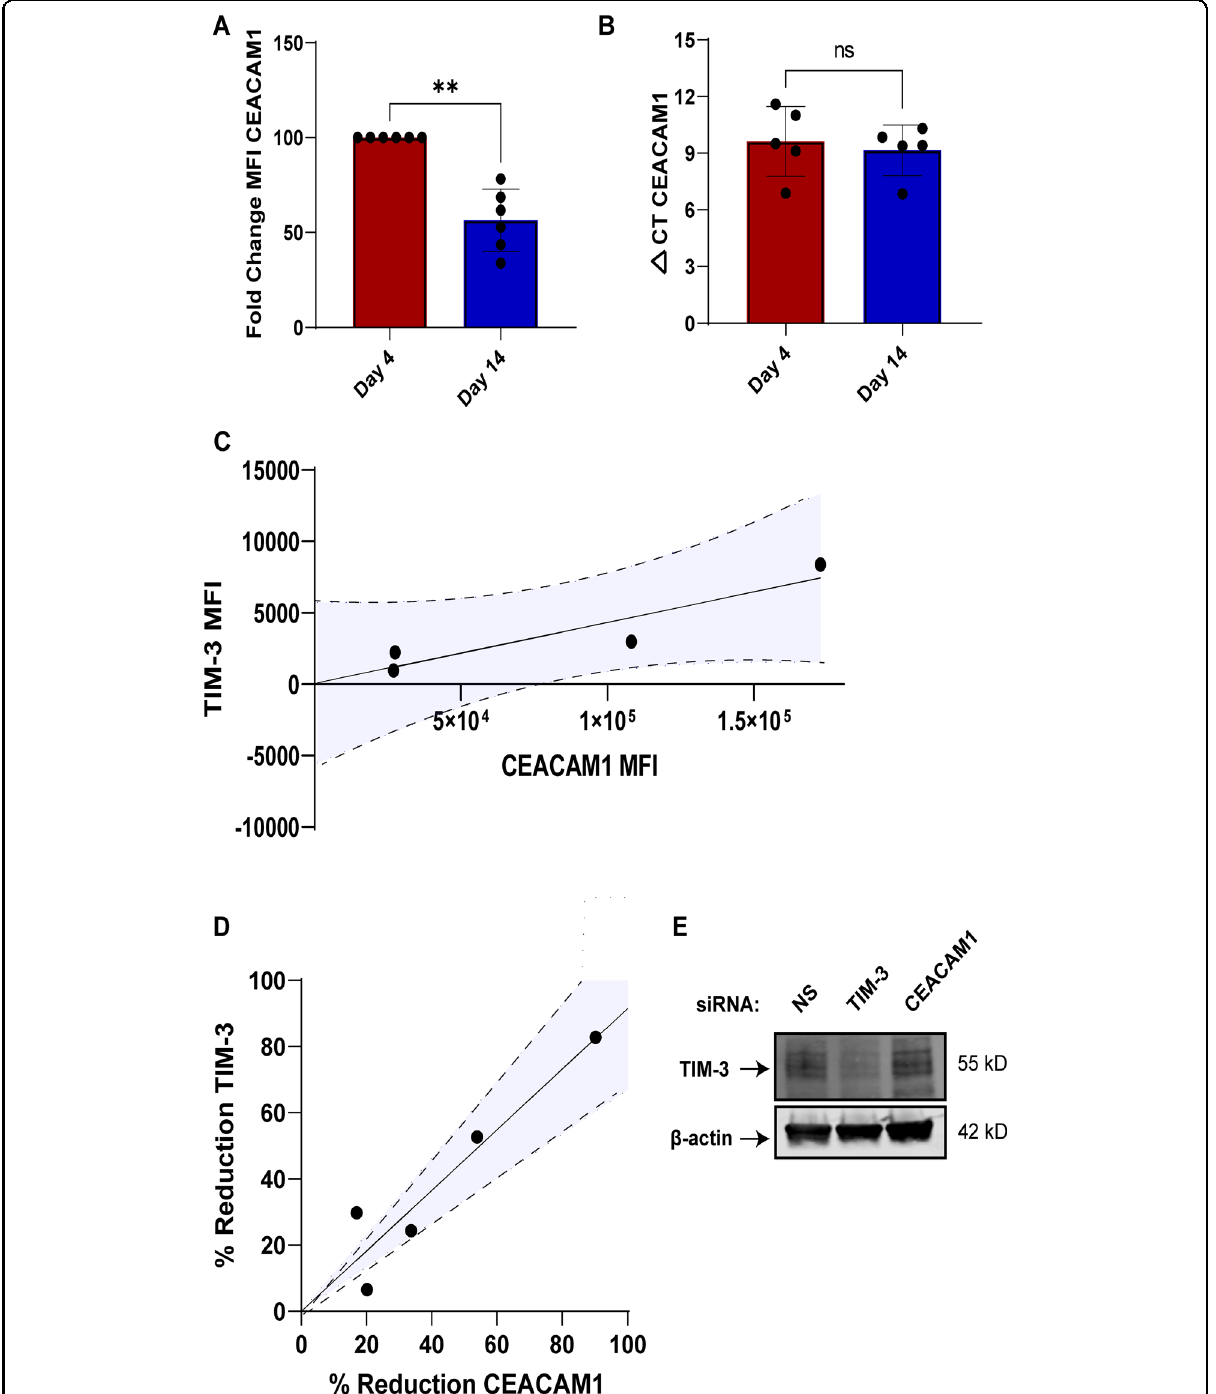
Fig. 6 TIM-3 cellular localization is dependent on CEACAM1 in primary CD8 + effector T cells. A CEACAM1 was assessed by fl ow cytometry (MFI) on days 4 and 14 post-activation; data normalized to day 4. B CEACAM1 mRNA was collected on days 4 and 14 post-activation and assessed by qPCR, normalized to 18S rRNA, and plotted as Δ Ct values. C CEACAM1 and TIM-3 MFI were plotted for individual donors on day 4 post-activation. Dotted lines represent 95% con fi dence intervals. D Cells from fi ve donors transfected with CEACAM1 siRNA on day 0 were assessed for both CEACAM1 and TIM-3 expression on day 4. Dotted lines represent 95% con fi dence intervals. E Representative western blot (of three donor replicates) probing for TIM-3 following either TIM-3 or CEACAM1 knockdown in newly activated cells (day 4). Statistical tests: A Mann – Whitney test, p = 0.0022; B paired t test, p = 0.6575; C simple linear regression and Pearson correlation, p = 0.0392; D simple linear regression and Pearson correlation, p =